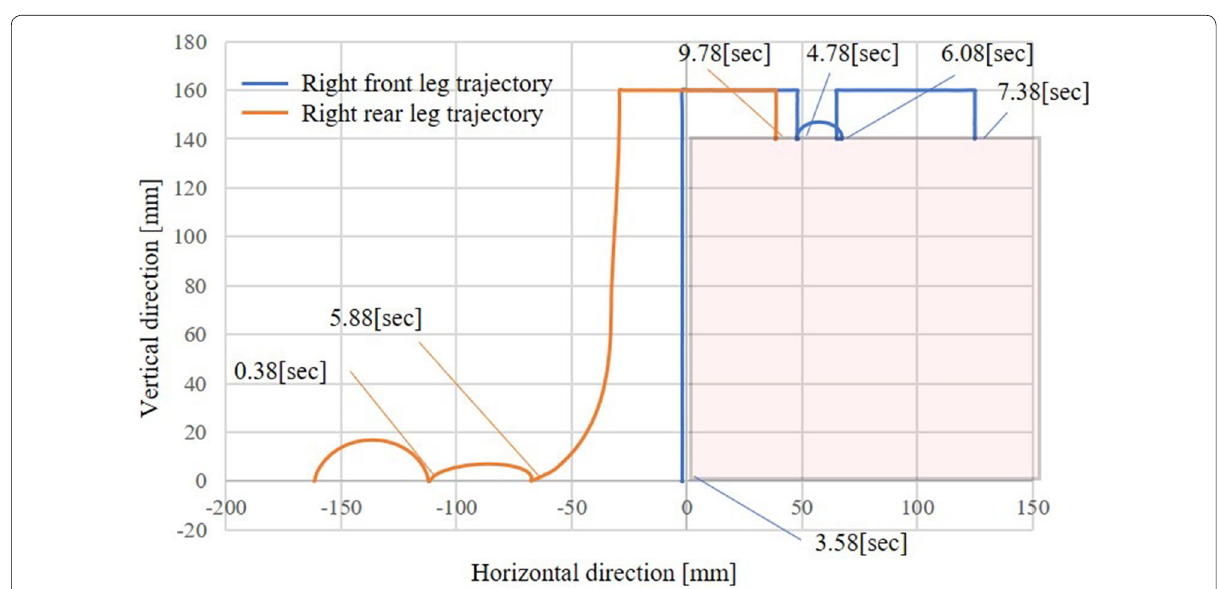
Fig. 22 Foot trajectory of climbing over a step (height is 140